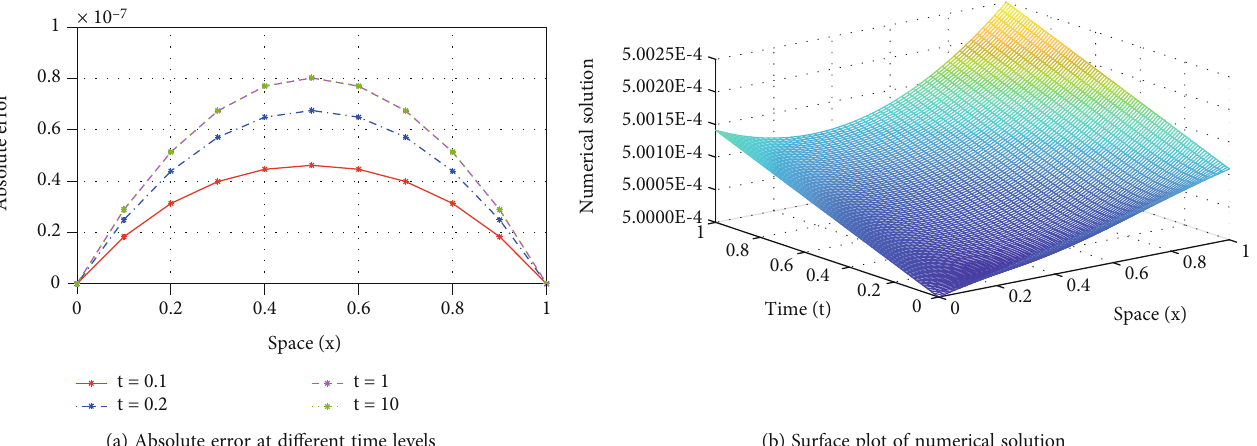
Figure 6: Error and solution pro fi le of Example 4 with N = 50 and Δ t = 0 : 01